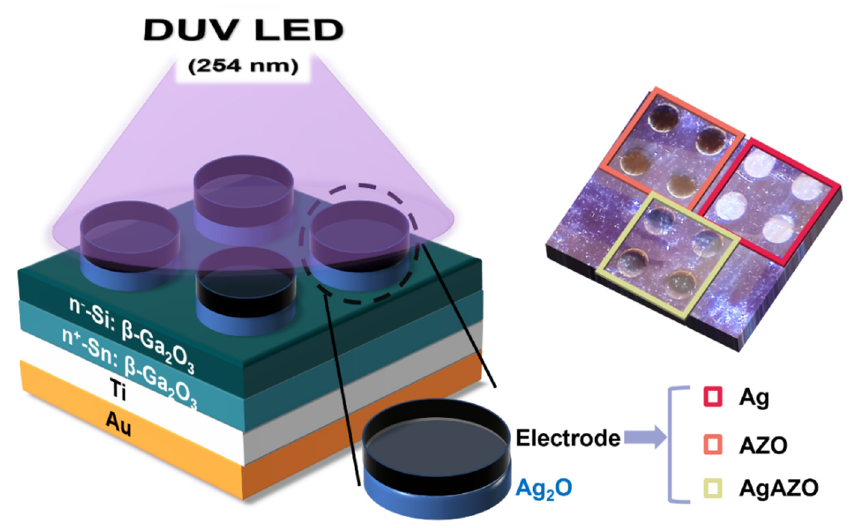
Figure 6 is the I–V curve for each thickness of a Ag 2 O/ β -Ga 2 O 3 photodetector based